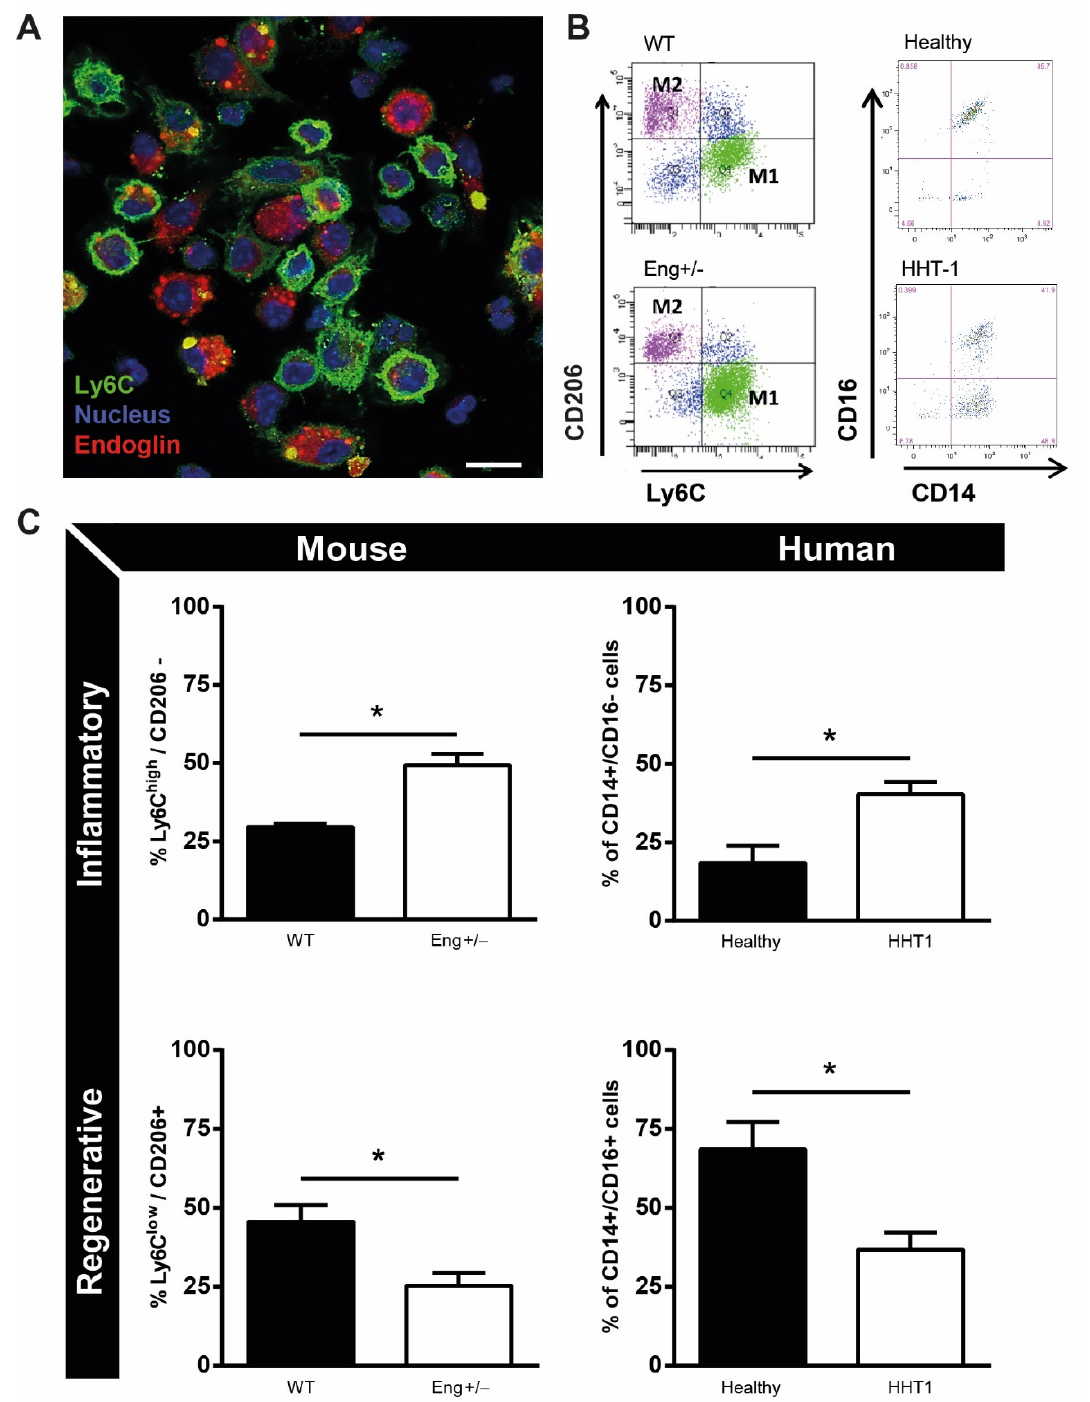
Figure 2. Macrophage phenotype is dependent on endoglin expression. ( A ) Macrophages isolated from Eng+/+ mice were stained with endoglin (red), Ly6C (green), and dapi (nuclei, blue). Scale bar: 10 µ m. ( B ) Representative flow charts of mouse and human isolated monocytes of Eng+/ − mice and HHT1 patients and their healthy controls. Mouse inflammatory mono- cytes were distinguished by CD11b+/Ly6Chigh/CD206- and regenerative monocytes by CD11b+/Ly6Clow/CD206+ expres- sion. Human inflammatory monocytes were distinguished by CD14+CD16- and regenerative monocytes by CD14+/CD16+ expression. ( C ) Quantification of the flow cytometry data as represented in B, divided in inflammatory and regenerative monocytes for mouse and human. Mouse samples: N = 5–16 mice per group. Eng+/+ N = 9, Eng+/ − N = 5. Human samples: 7 HHT1 patients and 5 age- and gender-matched healthy human volunteers. * p < 0.05.